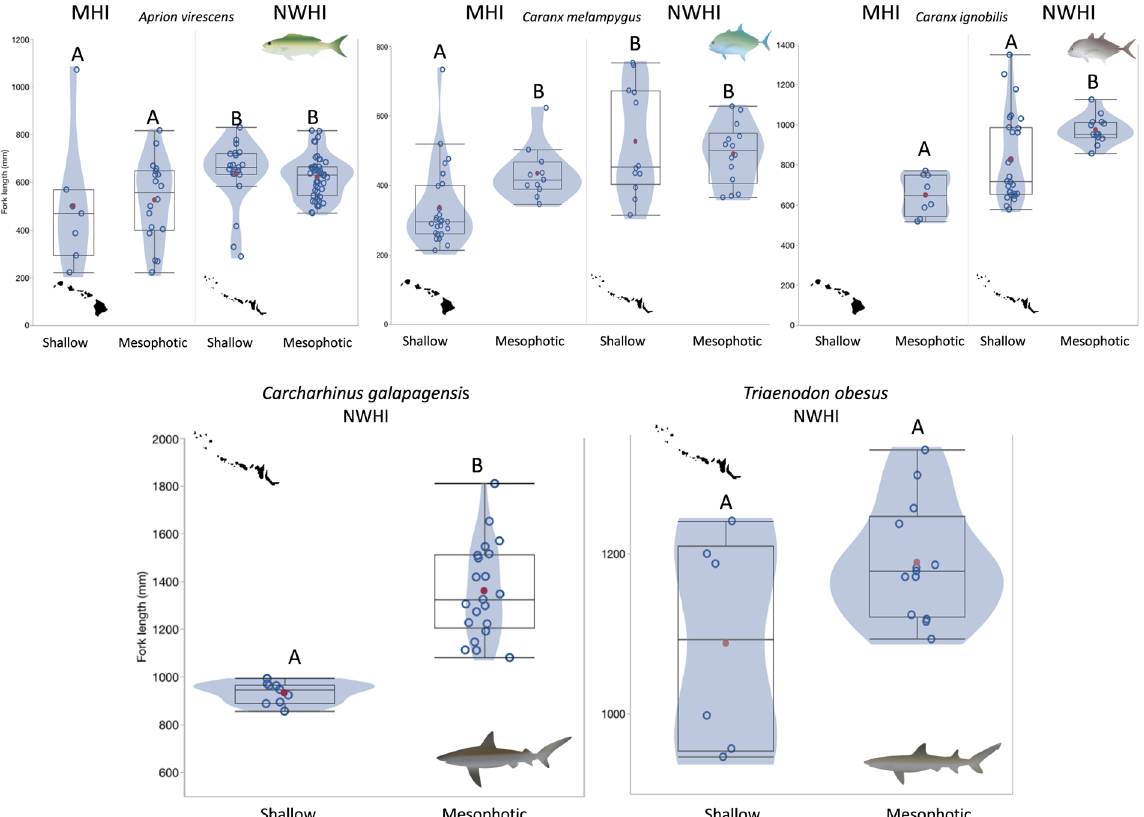
Figure 6. Box and whisker plots indicating fork-length size distributions for Aprion virescens , Caranx melampygus , Caranx ignobilis , Carcharhins galapagensis , and Triaenodon obesus . Whiskers indicate minimum and maximum values, the box specifies the lower interquartile range, and the solid black line indicates the median. Columns with the same letter are not significantly different (P > 0.05). Empty blue circles = individual fork-lengths, solid red circles = mean, shaded contour = density of measurements by length. Box and whisker plots generated in JMP statistical software, version 12.1.0 (http://www.jmp.com/). Maps in the figure were generated using Adobe Illustrator CS5